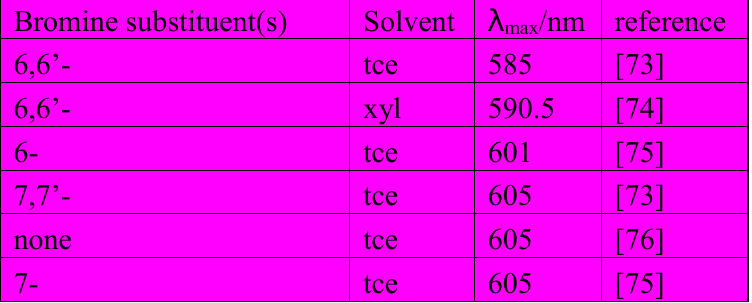
Table 2. Visible absorption spectrum maxima ( λ